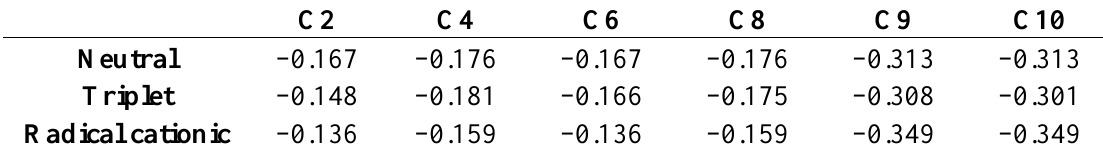
Table 1. Charge distribution on the carbon atoms for 2 compound.